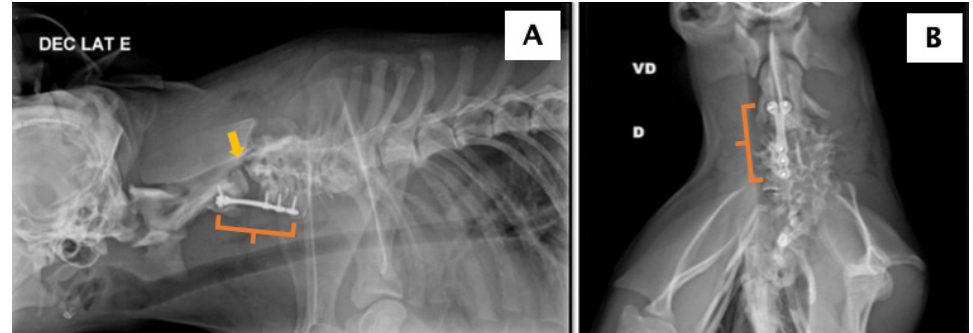
Figure 7. Radiographic images of the cervical-thoracic region of a 3-month-old male MBD dog, with congenital vertebral malformations, three months after surgical procedure to stabilize the cervical dynamic instability (C2 and C3-C4-C5 vertebrae). (Veterinary Hospital/UFRRJ–